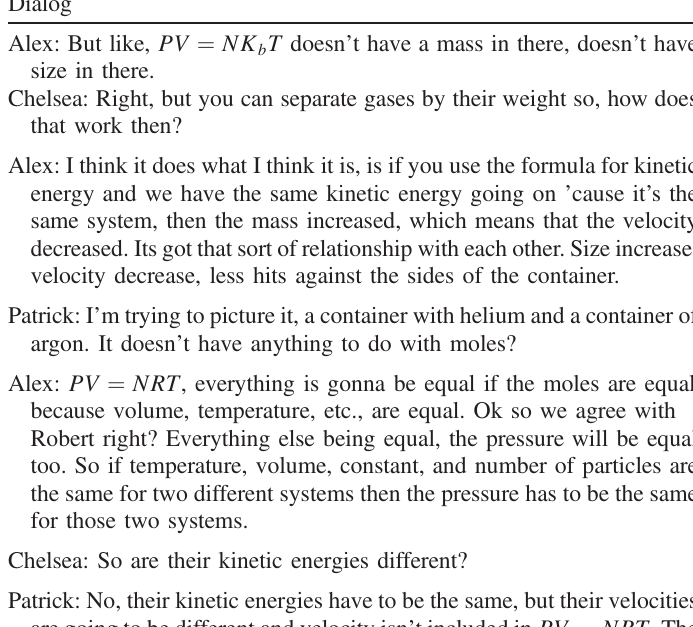
TABLE VI. Changing gas conversation B.